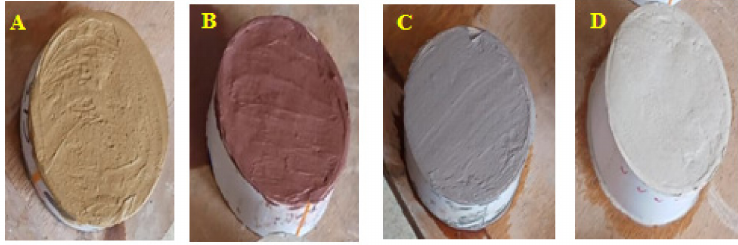
Figure 1. The different prepared clay